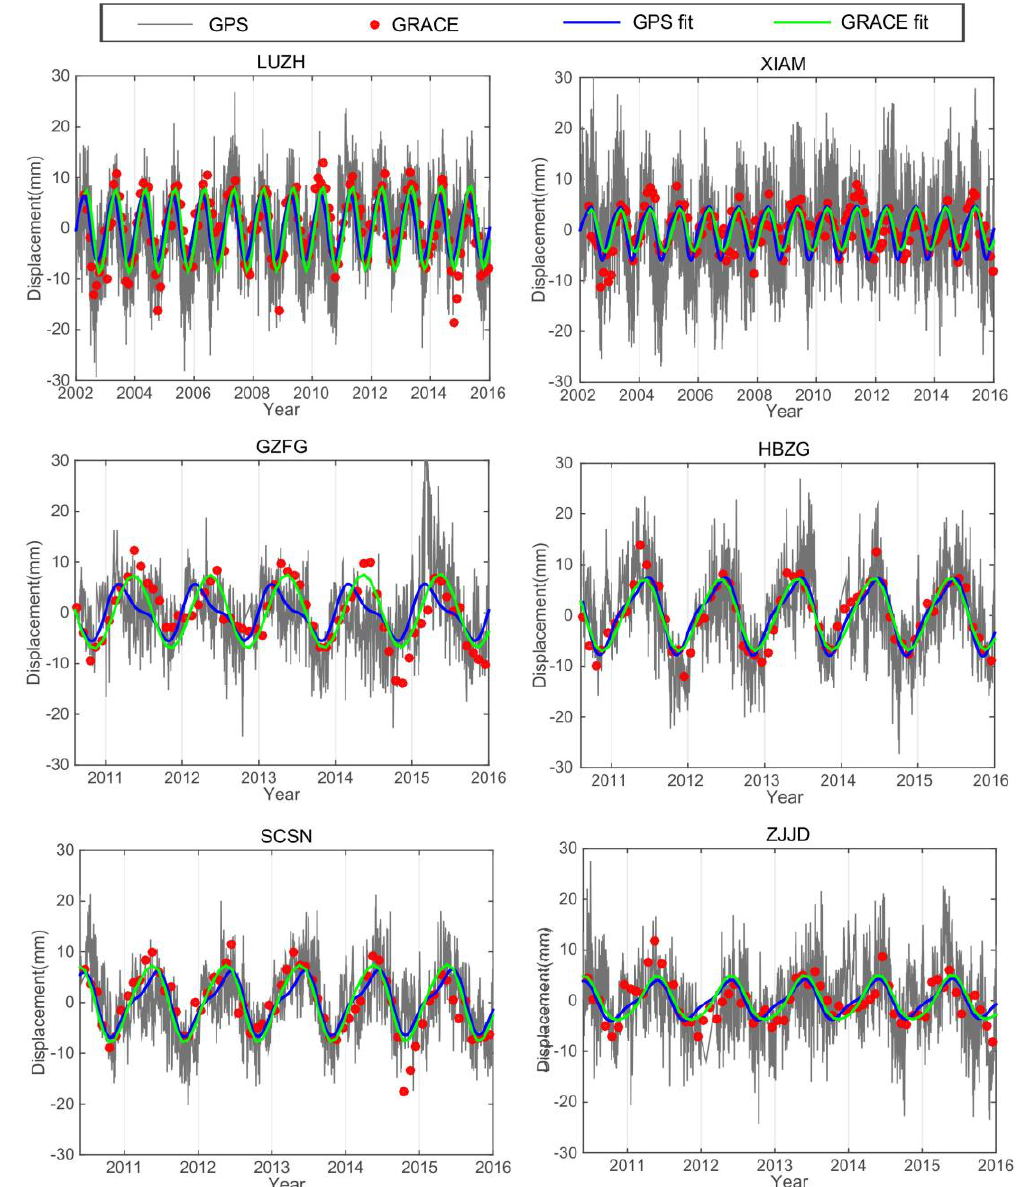
Figure 4. The seasonal variations comparison between de-trended continuous GPS and GRACE-modeled loading time series in Southern China, and example time series for sites LUZH, XIAM, GZFG, HBZG, SCSN and ZJJD (red dots in the location map). LUZH and XIAM have longer observational time than other four GPS sites. Blue and green solid lines are fitted by least square (annual plus semi-annual components) for GPS and GRACE, respectively.